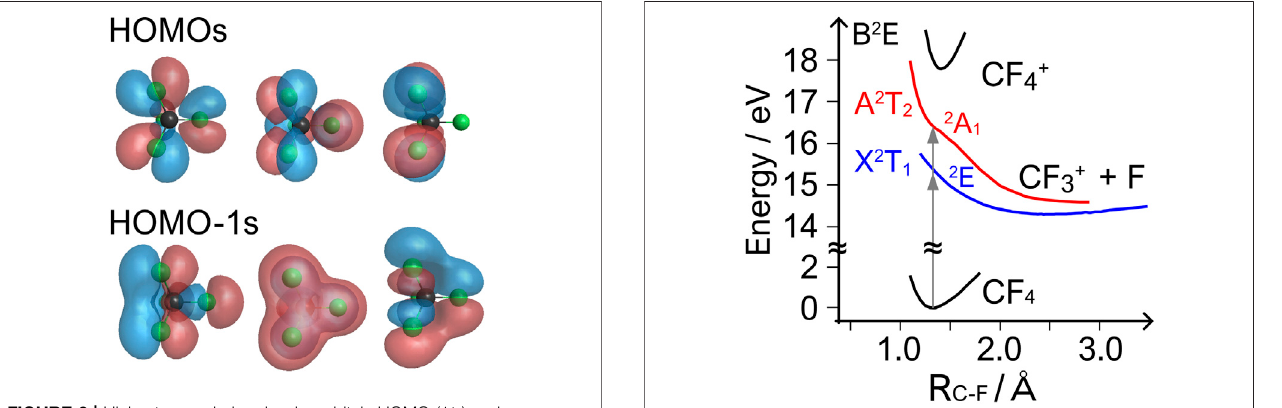
FIGURE 3 | Highest-occupied molecular orbitals HOMO (1 t 1 ) and HOMO-1 (4 t 2 ). Both HOMO and HOMO-1 are triply degenerated. FIGURE 4 | Schematic potential energy curves of selected electronic states of CF 4 and CF + 4 as a function of the internuclear distance R C-F between F and C in the CF 3 group [reproduced from Tang et al.